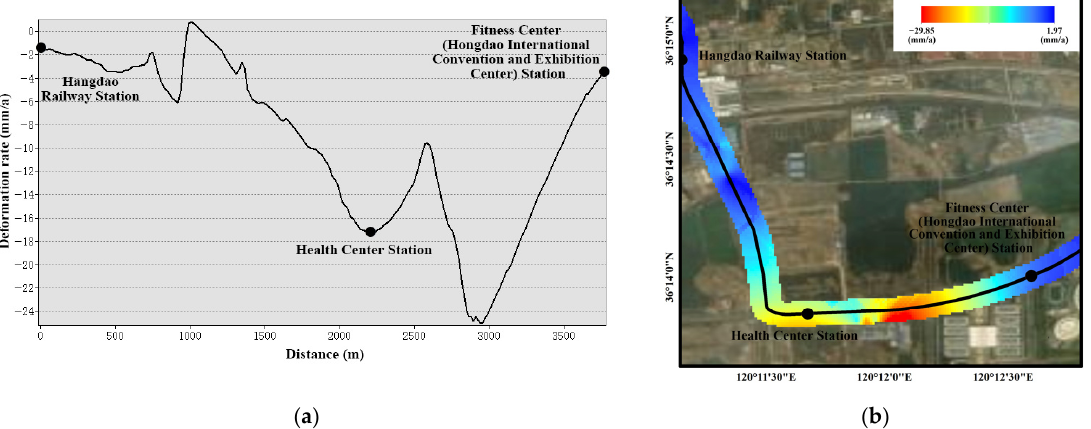
Figure 12. The subsidence of Hongdao Railway Station-Health Center Station-Fitness Center (Hongdao International Convention and Exhibition Center) Station: ( a ) the profile and ( b ) the buffer. Area B: This area included reservoirs/ponds, saline-alkali land, bare rock and gravel,